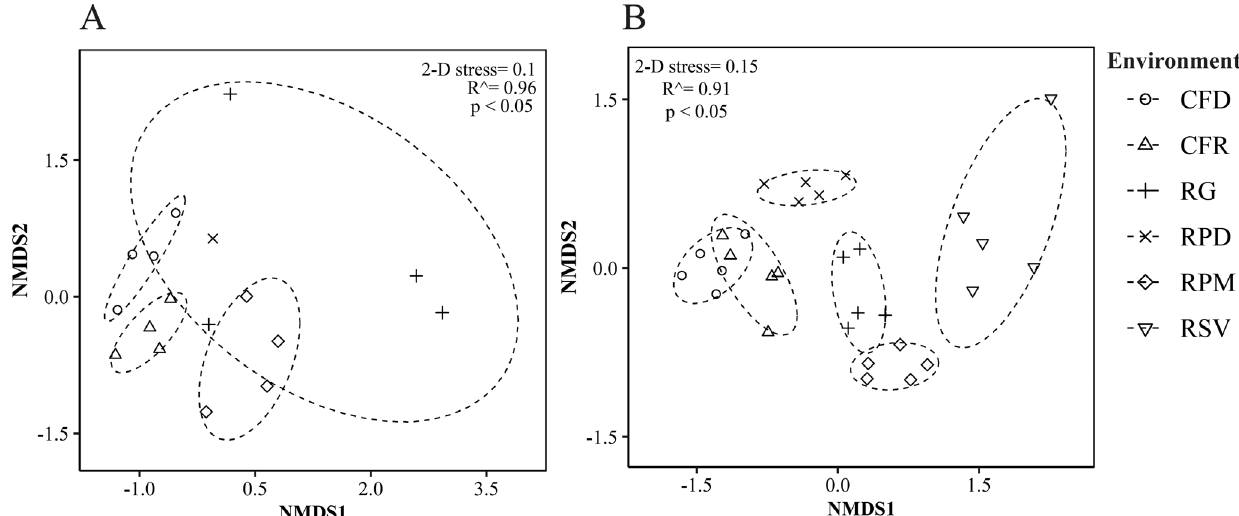
FIGURE 5 | Fish-assemblage ordination in the aquatic environments of Porce III by non-metric multidimensional scaling (nMDS) using Jaccard similarity index. A. Before filling the reservoir from 2008 to 2011 and B. After filling the reservoir from 2017 to 2020. Environments are identified by symbols, and assemblage groups are identified by lines (70% of similarity). (RPM) Porce River isolated between the dams, (RG) Guadalupe River, (RSV) Reservoir, (CFR) Creeks flowing to the reservoir, (CFD) Creeks flowing to the Porce River below the dam, and (RPD) Porce River below the Porce III